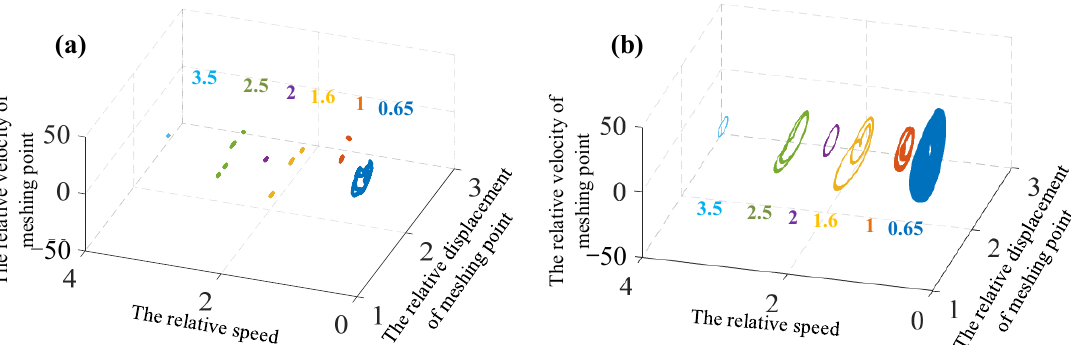
Figure 19. System response diagram with ζ = 0.01. ( a ) Poincare section diagram. ( b ) Phase diagram.